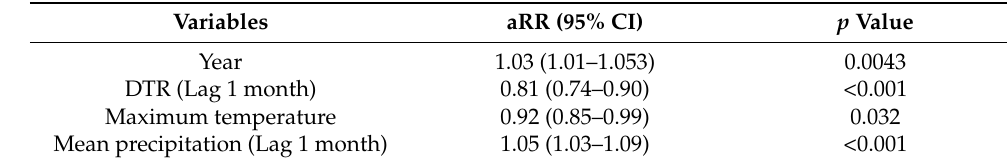
Table 1. Final multivariable model for association of meteorological variables with dengue cases 2000–2013 in the final adequate